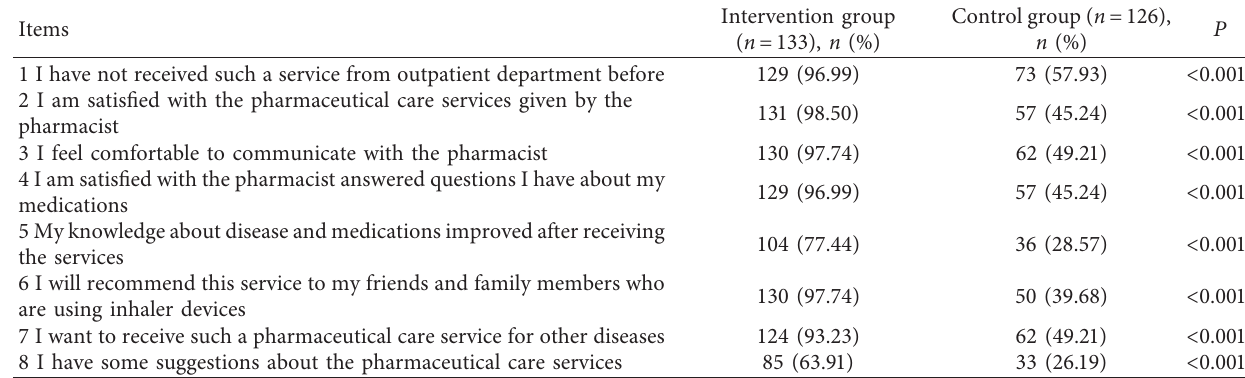
Table 5: Patient satisfaction in the intervention group and control group postintervention.